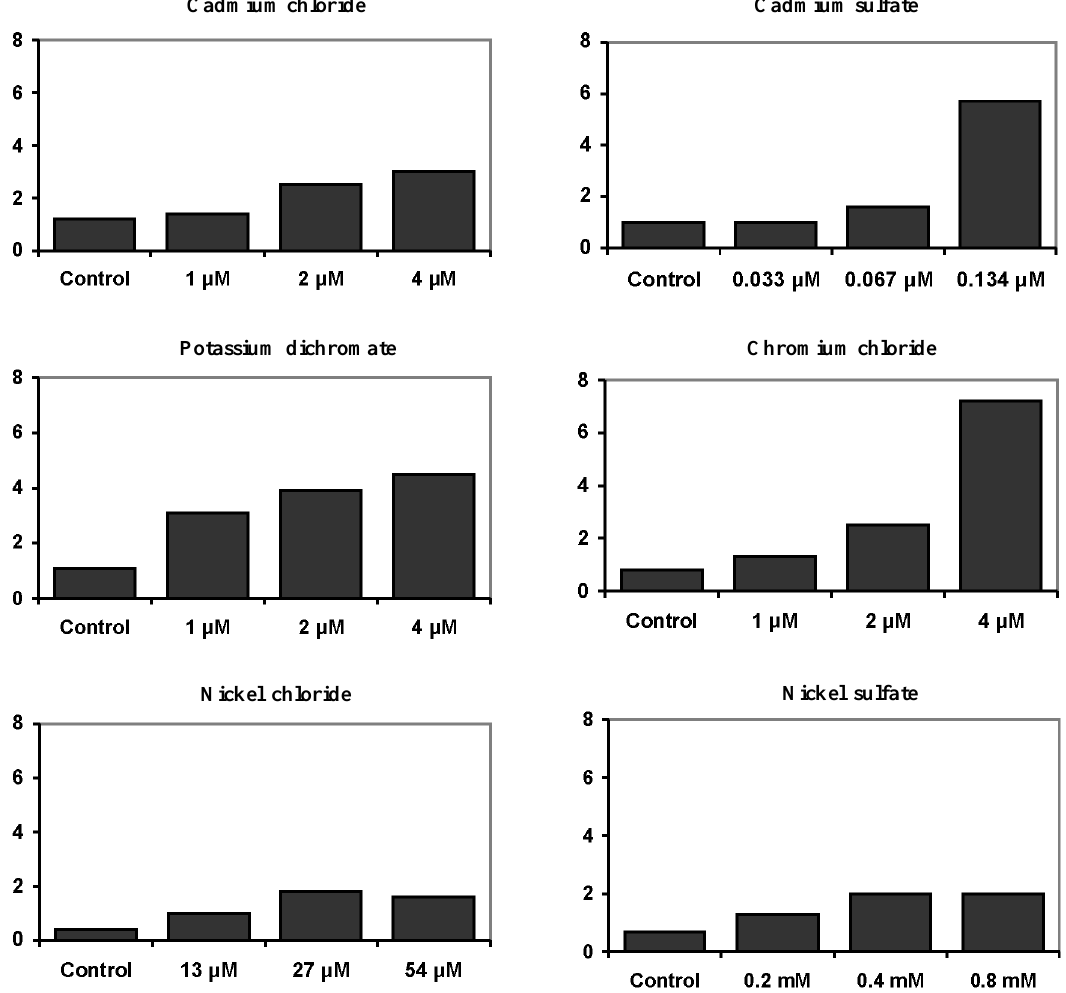
Figure 5 - Frequencies of lagging chromosomes induced by different metal salts in anaphase-telophase of CHO